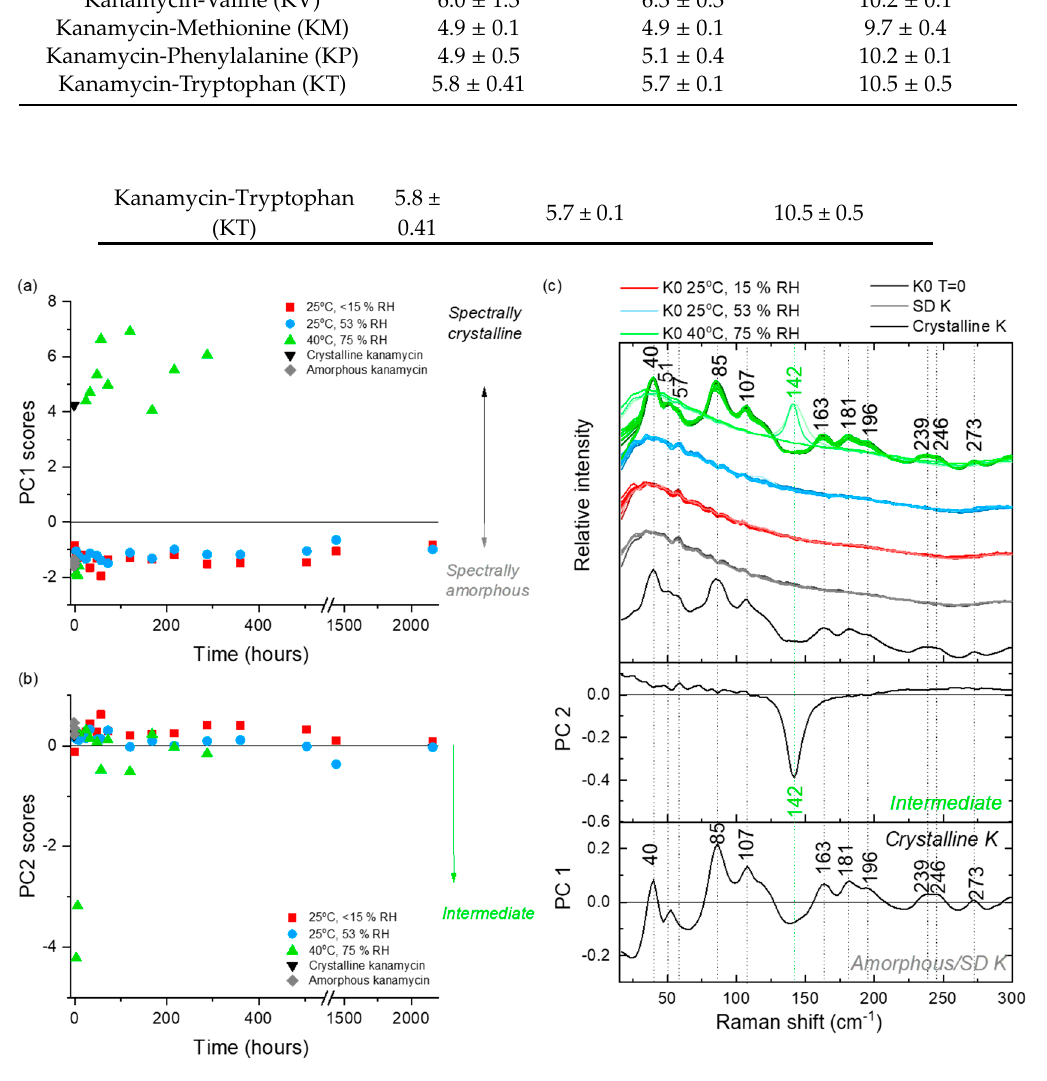
Figure 5. PCA analysis of the LFR spectra collected from KO samples stored under three different conditions (25 °C/<15% RH, 25 °C/53% RH and 40 °C/75% RH) over time. ( a ) PC 1 scores versus time, ( b ) PC 2 scores versus time and ( c ) loadings with comparative spectra. PC 1 accounts for 88% of the explained spectral variance and PC 2 accounts for a further 8% explained variance. Spectra from the different storage conditions in ( c ) have slight color graduations to highlight early (lighter coloring) versus latter (darker coloring) time points.